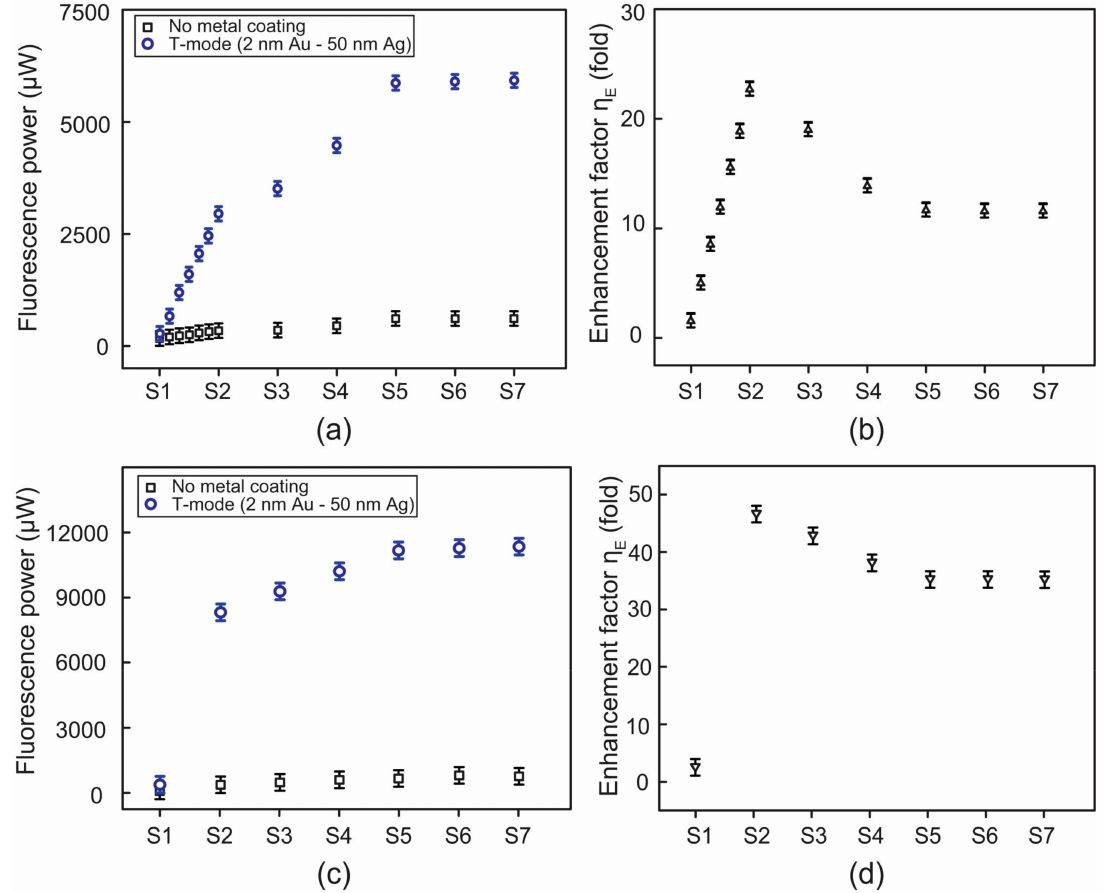
Figure 4. FAM concentrations (C FAM )-dependent fluorescence power and fluorescence enhancement factor ( η E ). ( a , b ) refer to a T-mode setup while ( c , d ) to an R-mode one. S1–S7 (see Figure 3) correspond to FAM concentrations, i.e., 5, 10, 15, 20, 25, 30, and 35 nM,